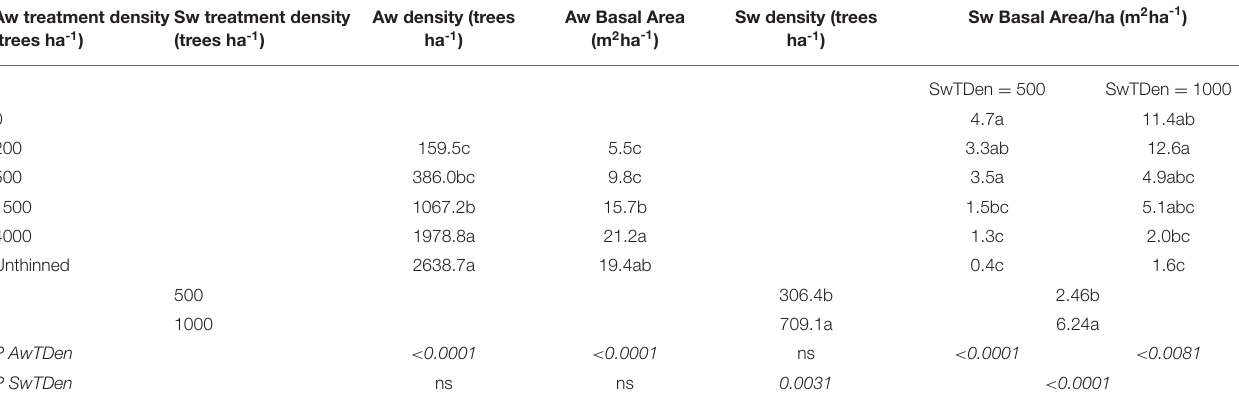
TABLE 1 | Effects of thinning treatments applied at age 5 on stand density and stand basal area at age 26. Aw treatment density (trees ha -1